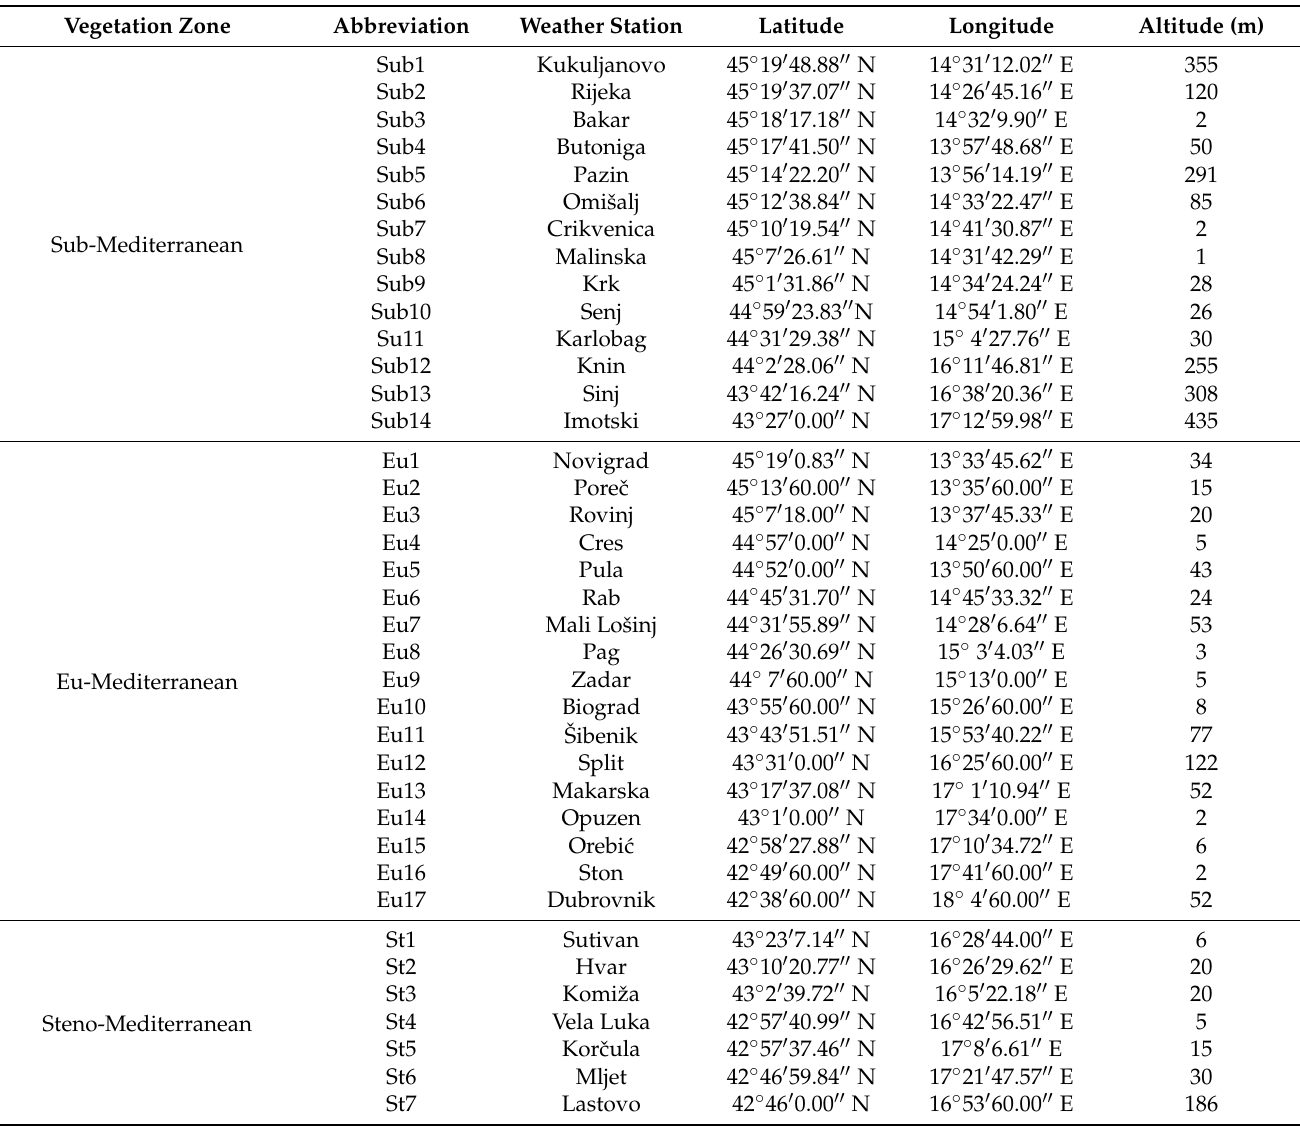
Table 1. List of weather stations in the vegetation zones of the Mediterranean vegetation belt along the eastern Adriatic